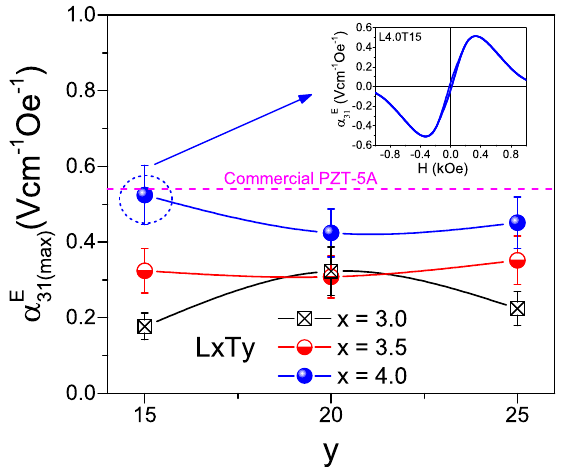
Figure 10. Maximum transverse magnetoelectric (ME) coefficient α E 31(max) , simulated in 2D, as a function of the composition of the piezoelectric phase (LxTay) for three-layer composites CFM25/LxTay/CFM25 and for a geometrically identical three-layer of CFM25/PZT-5A/CFM25 (dashed line). Inset shows α E as a function of the bias magnetic field (H) for the three-layer 31 CFM25/L4.0Ta15/CFM25.